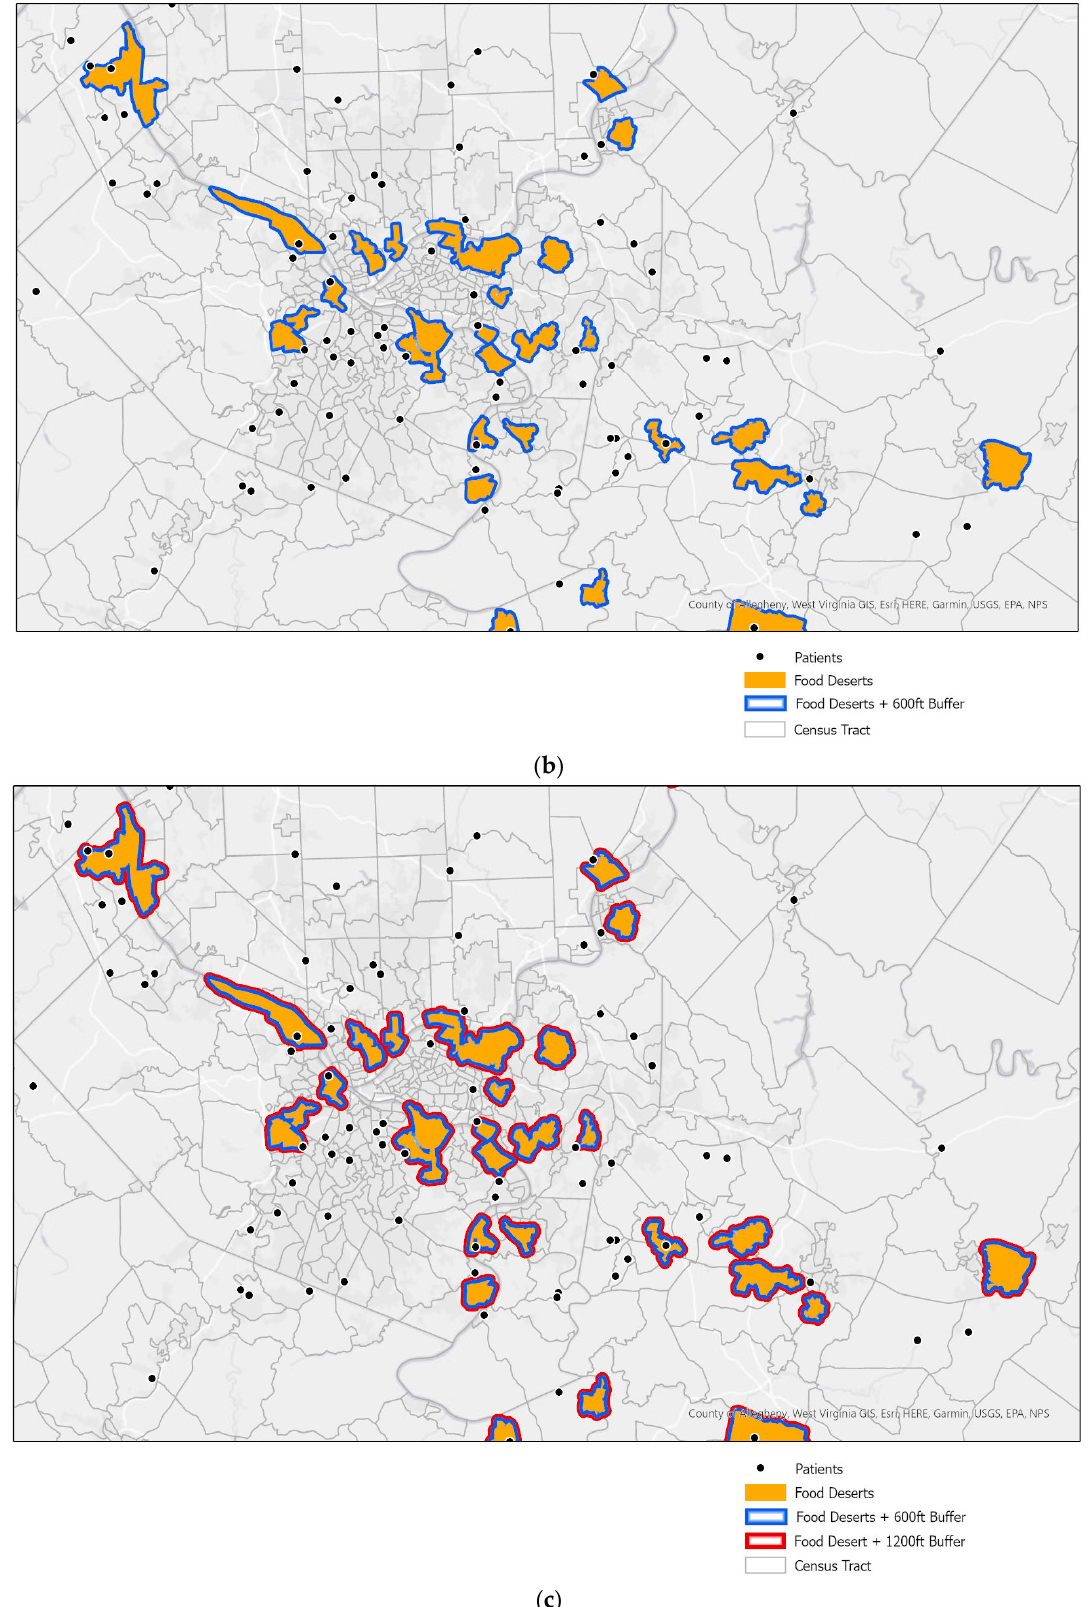
Figure 1. ( a ) Zoomed in spatial overlay of food deserts (Allegheny County, PA, USA) and patient sample. ( b ) Zoomed in spatial overlay of food deserts (Allegheny County, PA, USA) plus a 600 ft buffer and patient sample. ( c ) Zoomed in spatial overlay of food deserts (Allegheny County, PA, USA) plus a 1200 ft buffer and patient